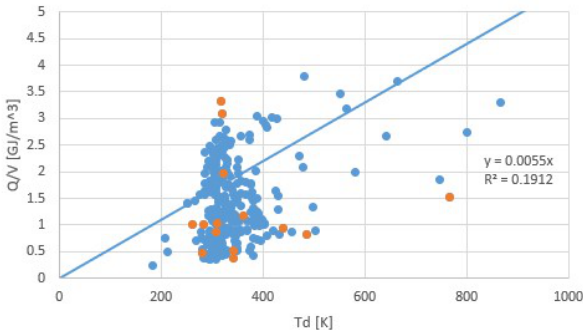
Figure 12. Heat storage densities Q / V (GJ/m 3 ) for salt hydrates, obtained for the same collection as Figures 10 and 11 for cases for which we found hydrate densities ρ (kg/m 3 ). Orange points are transitions with the lowest and highest transition entropies. We see that due to hydrate densities and the amount of water in the transition, Q / V shows no clear correlation with T d , according to r 2 = 0.19.